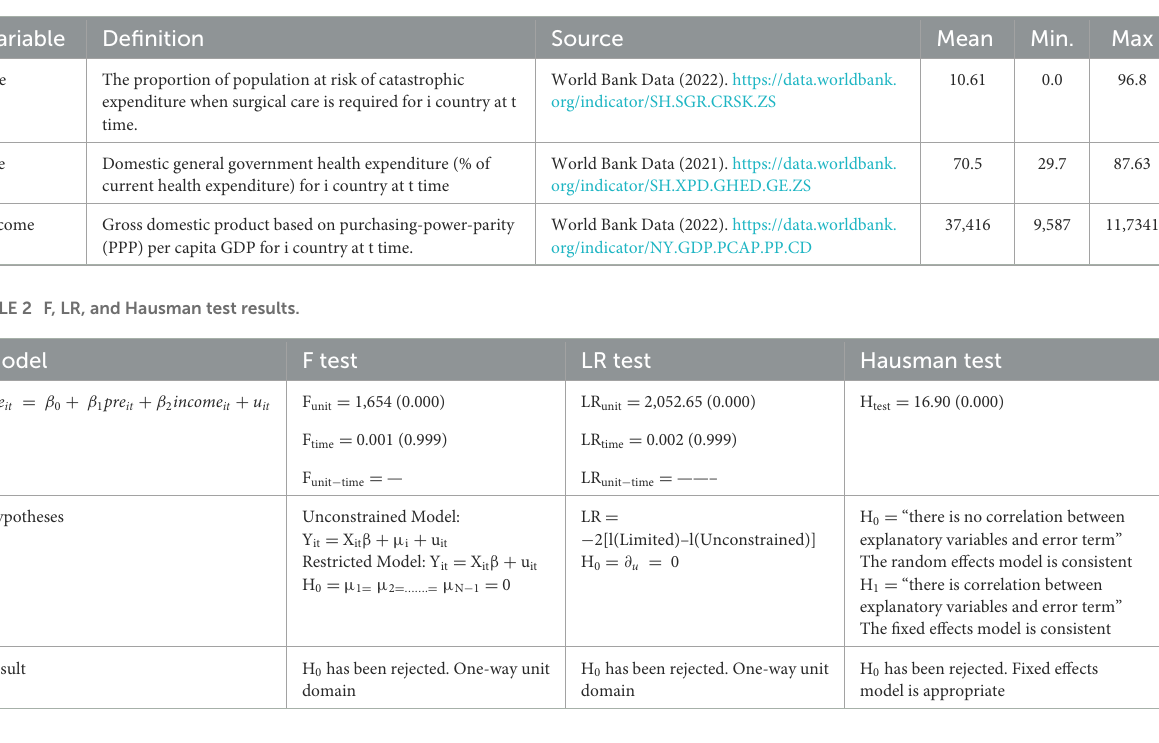
TABLE 1 Explanations about variables in the model and descriptive statistics.